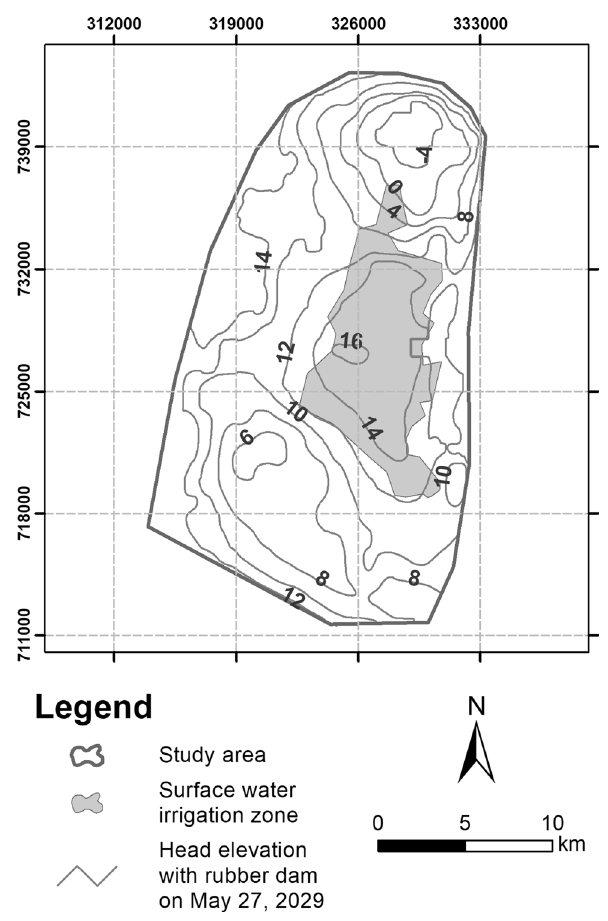
Fig. 11 GWL contour map on May 27, 2029, for scenario-2 showing the lowest GWL of − 4 mPWD to the north of the model area where Nachole and Gomastapur Upazilas are located. The highest GWL (16 mPWD) is seen at the center of the model domain, which lies inside the surface water irrigation